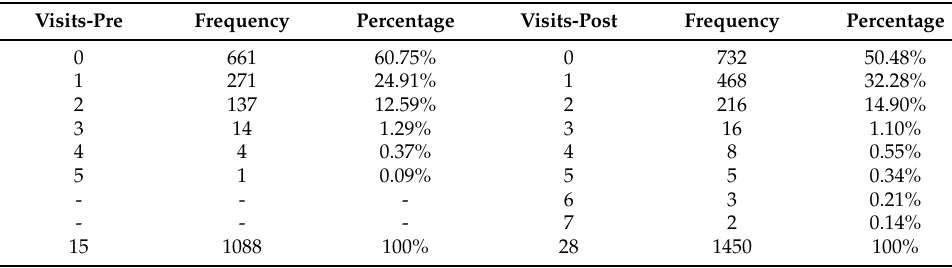
Table 5. Number of visits that achieved digital